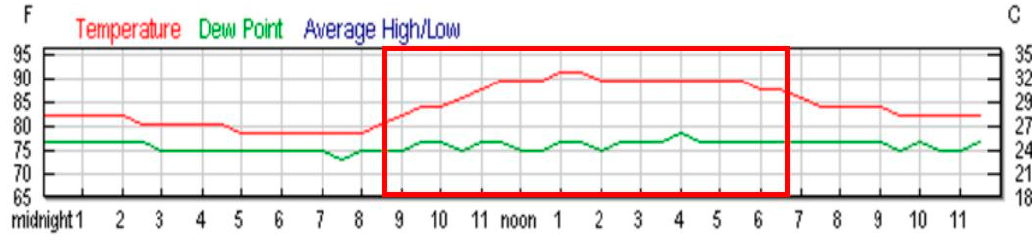
Figure 10. Air temperature in Kuala Lumpur on 18 March 2016.